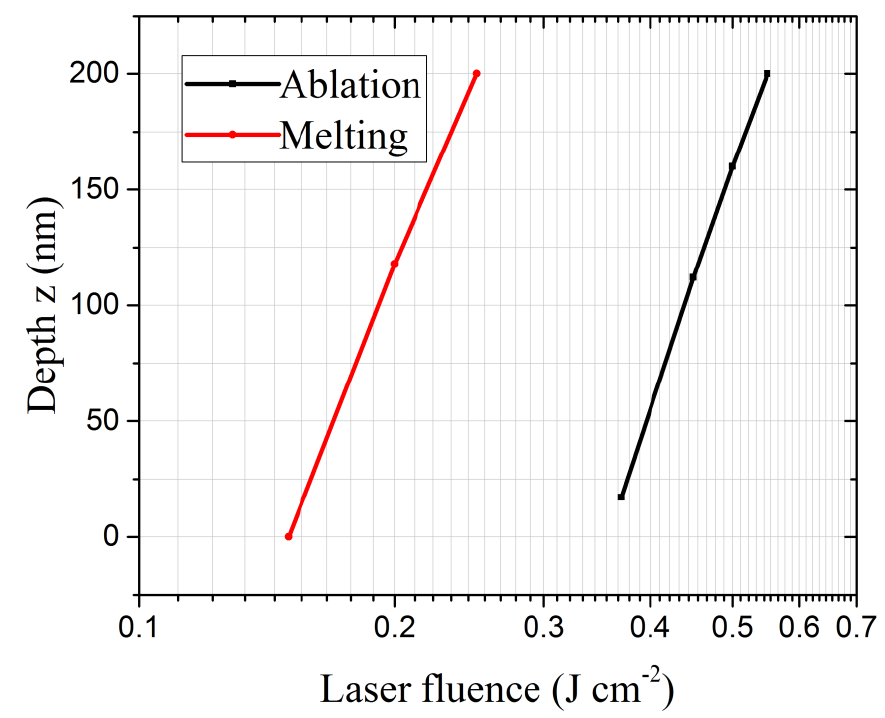
Figure 3. Melting and ablation depths as a function of laser fluence.